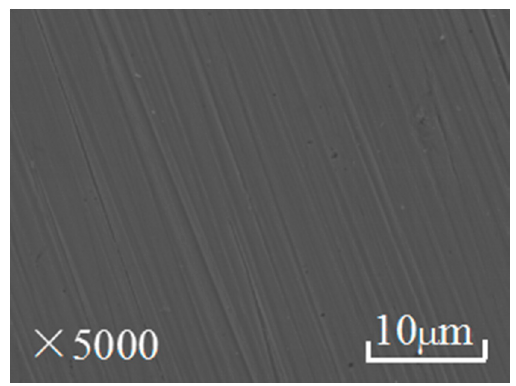
Figure 9. SEM images of the C-steel surface after sanding.